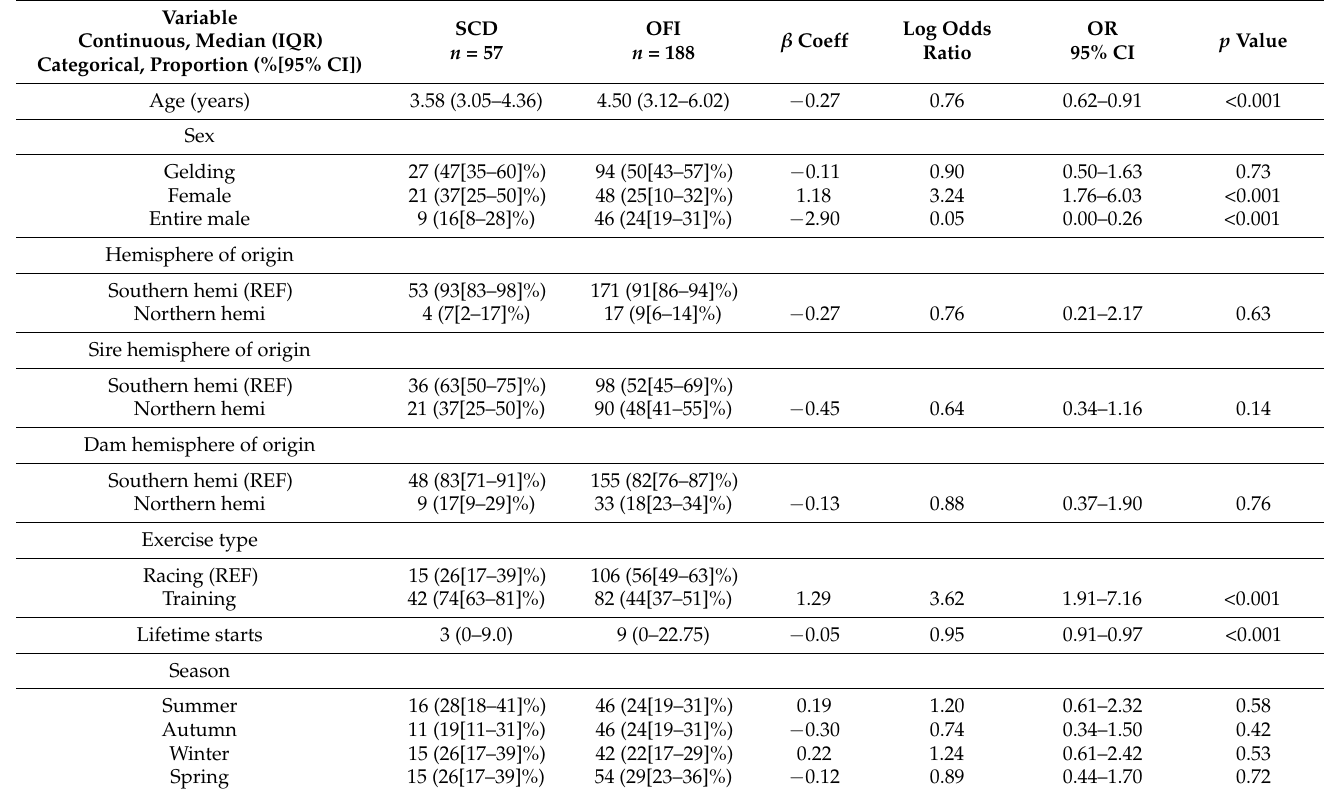
Table 1. Univariable logistic regression of relationship between each examined variable and SCD. Variables with p < 0.25 were submitted to the final multivariable model.